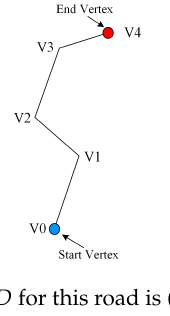
Figure 7. CD of two roads. Note that V0–V4 represent the vertices of the roads. V0 and V4 respectively represent the starting and end vertices of the